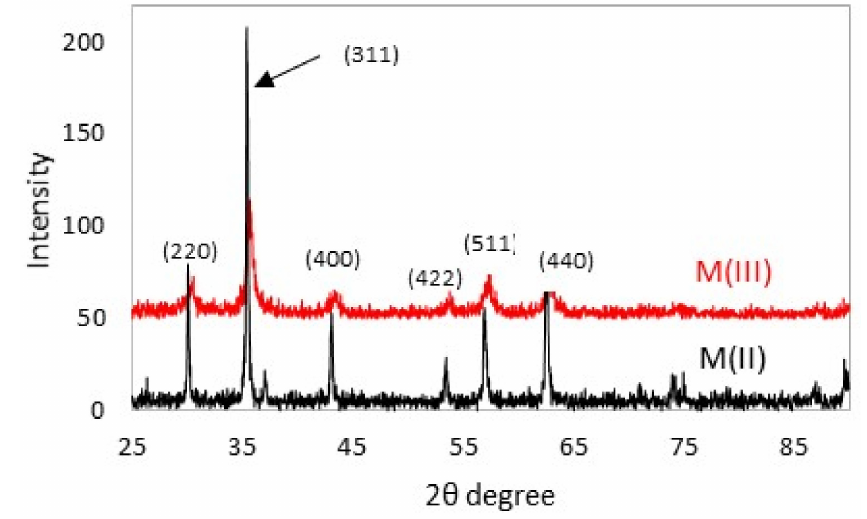
Figure 2. XRD pattern of